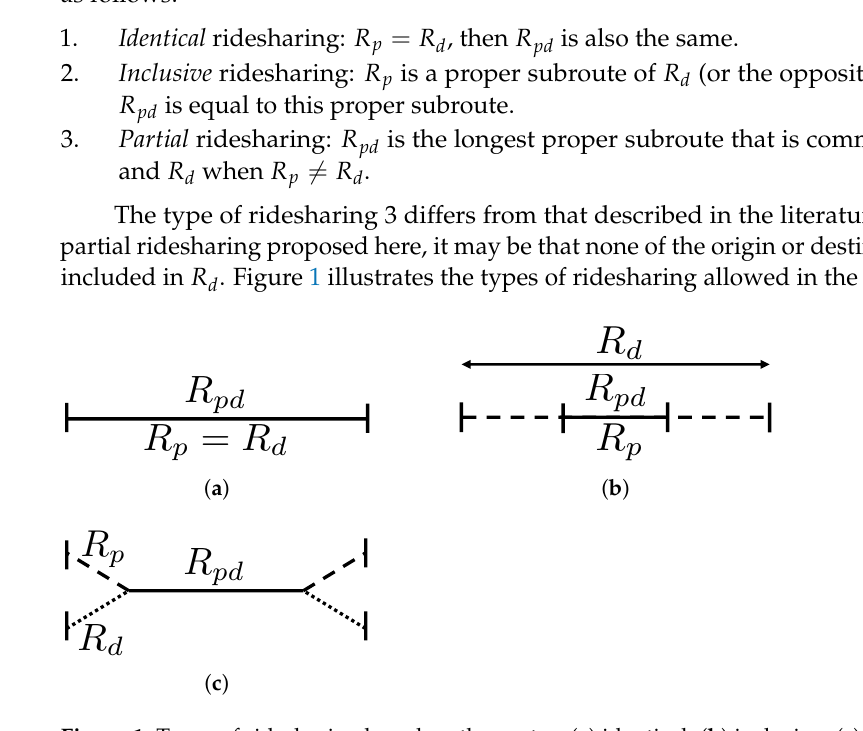
Figure 1. Types of ridesharing based on the routes. ( a ) identical. ( b ) inclusive. ( c )